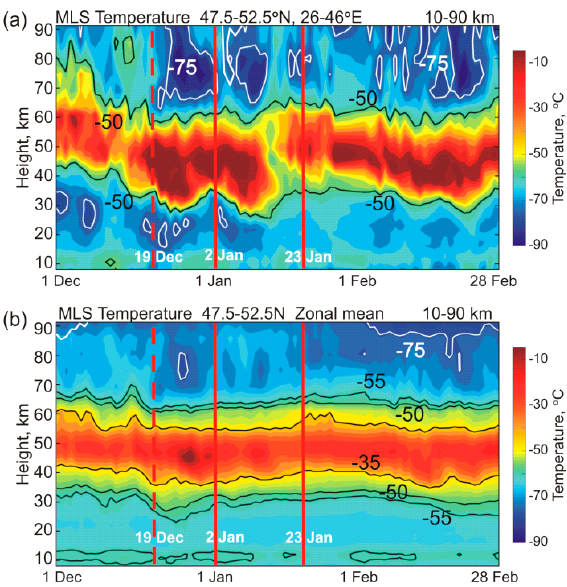
Figure 6. Temperature altitude profiles by Aura Microwave Limb Sounder (MLS) data [42] for SSW2 in winter 2019: ( a ) Over the Kharkiv region, and ( b ) zonal average in the band 47.5–52.5°N. It appears that the change between the elevated and descended stratopause over the station